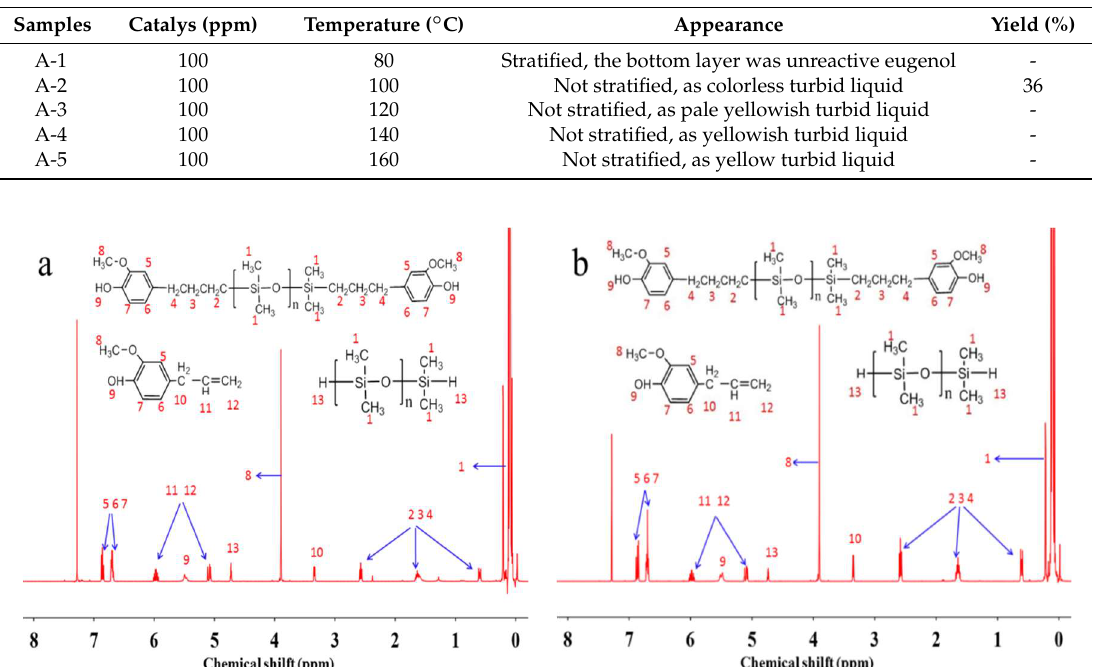
Figure 2. Nuclear magnetic resonance hydrogen ( 1 H NMR) spectrum of sample A-2 ( a ) and A-10 ( b ).